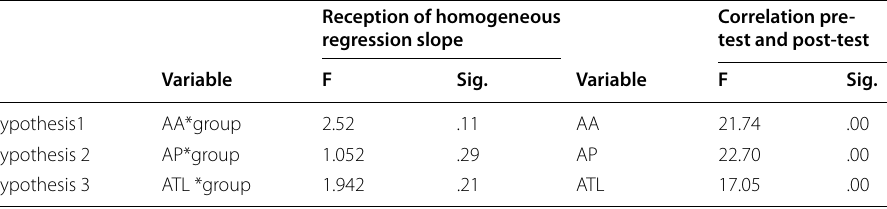
Table 3 Regression slope homogeneity test and confirmation of the effect of the auxiliary variable